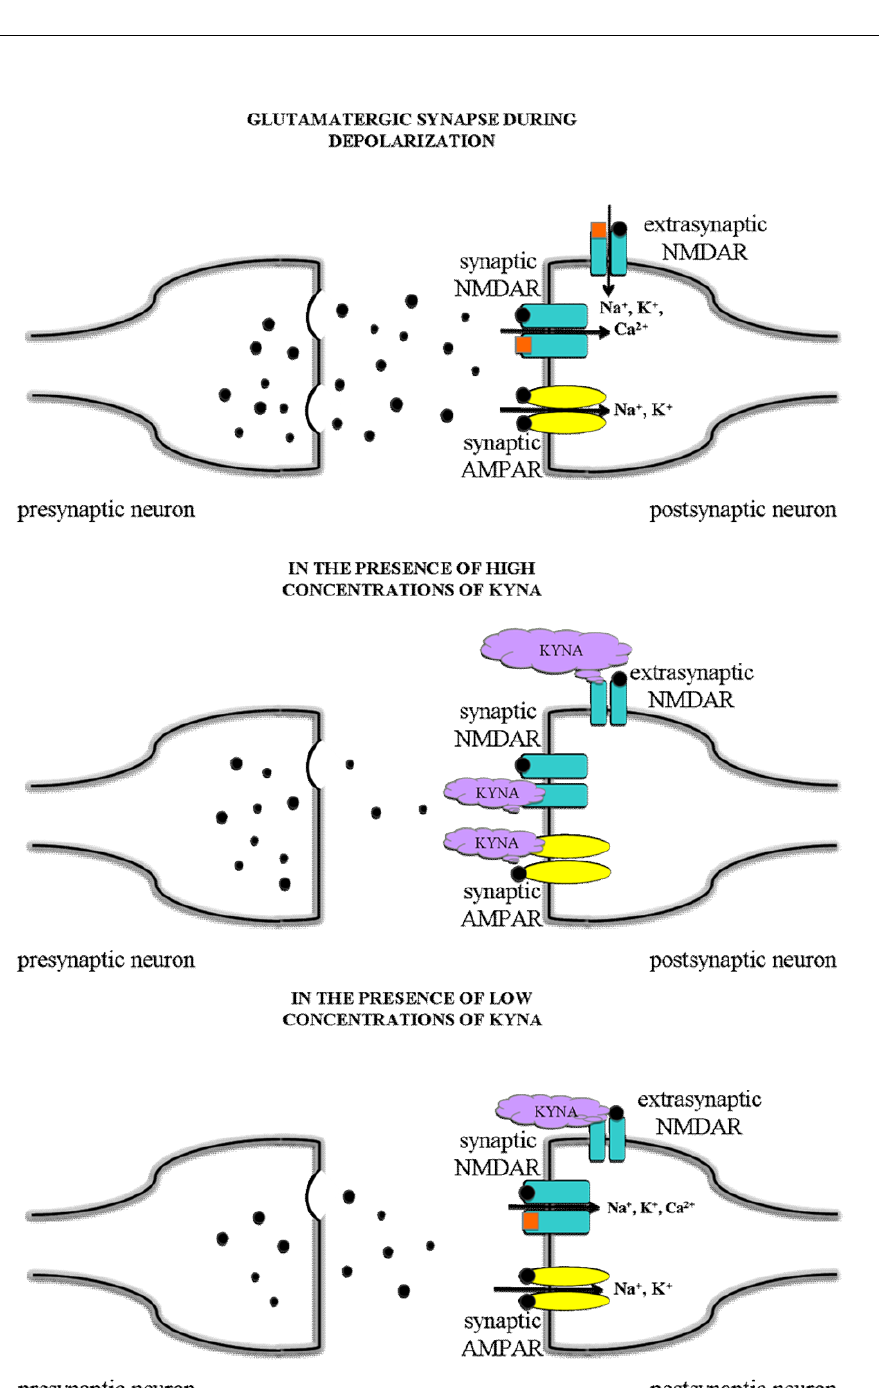
Figure 4. Hypothetical mechanisms, receptorial and current alterations in normal conditions of glutamatergic neurons and in the presence of KYNA in different dose. A slight increase in the level of KYNA in the postsynaptic area may exert a preferential inhibition on the extrasynaptic NMDA receptors, thereby being able to protect against excitotoxic neuronal injury.